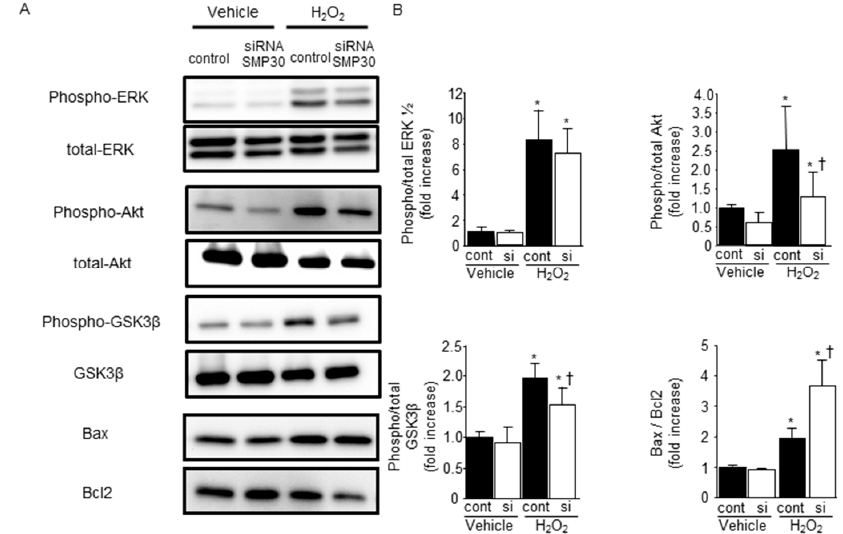
Figure 5. Effect of SMP30 silencing on survival signaling and apoptosis-associated proteins in cardiomyocytes: ( A ) representative Western blots from SMP30 siRNA and control siRNA cardiomyocytes subjected to 1 h of H 2 O 2 stimulation; ( B ) Silencing SMP30 attenuated phosphorylation of Akt and GSK-3 β and increased the ratio of Bax to Bcl-2 expression. Quantitative and statistical analyses of Western blots are shown. Data are represented as mean ± SE ( n = 8), * p < 0.05 vs. vehicle control siRNA, and † p < 0.05 vs. H 2 O 2 control.